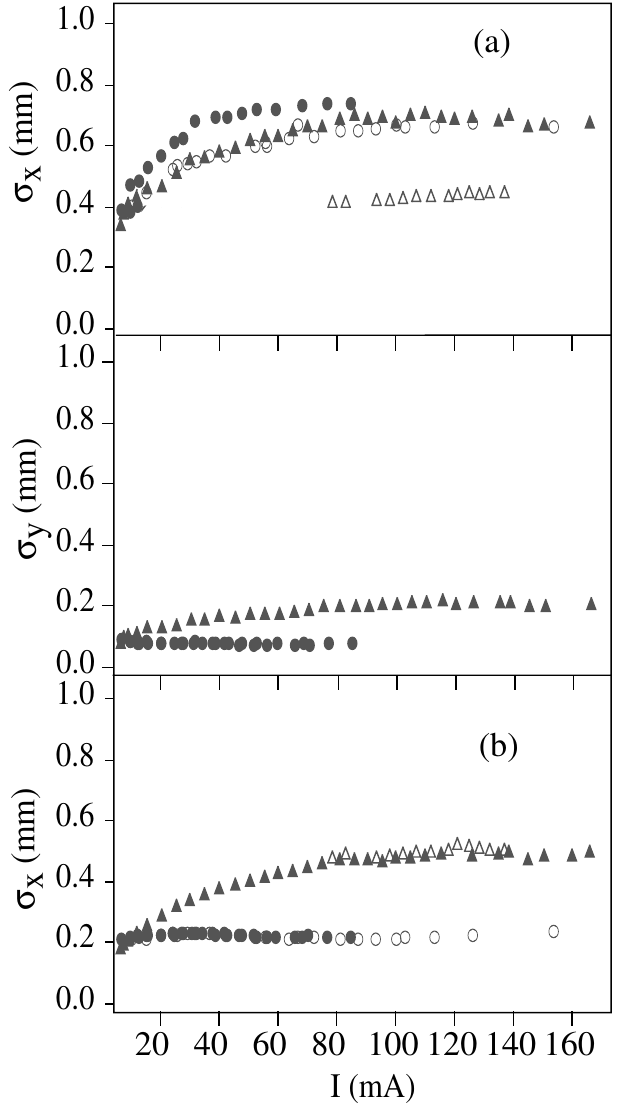
FIG. 6. Transverse size versus current FEL on, measured on (a) BL2 and (b) BL3, under different conditions: achromatic optics: ( (cid:2) ) P (cid:6) 0 : 3% , ( (cid:12) ) P (cid:6) 0 : 12% ; chromatic optics: ( (cid:3) ) P (cid:6) 0 : 3% , ( 4 ) P (cid:6) 0 : 12%